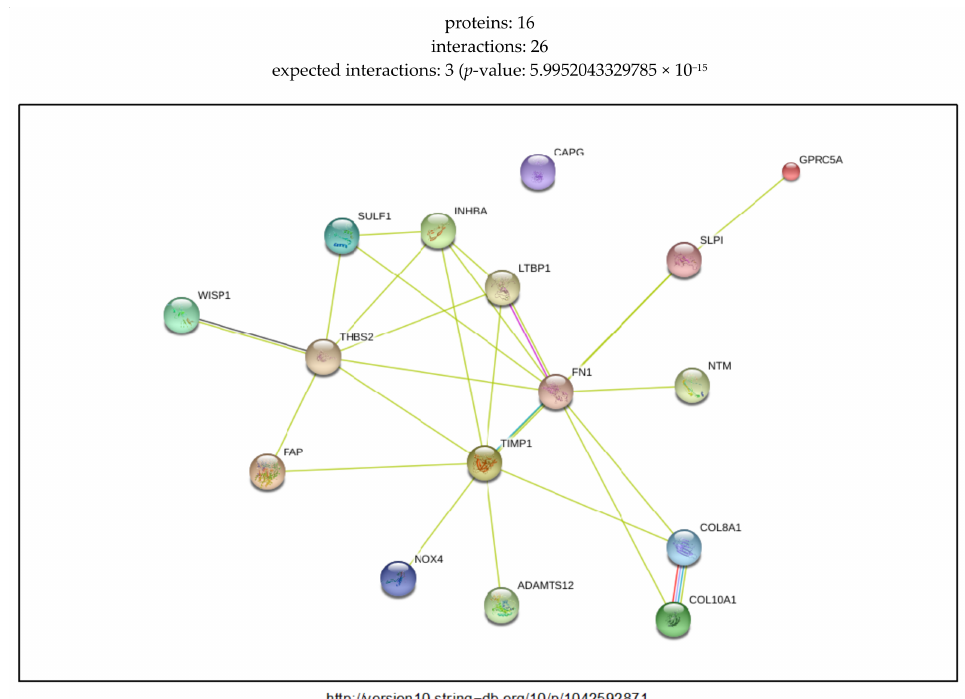
Figure 10. Predicted protein–protein interactions using the STRING database for the PDAC GRN genes. Edges represent interactions between proteins, and multiple edges represent additional sources of evidence. Analysis was performed with String v. 10.